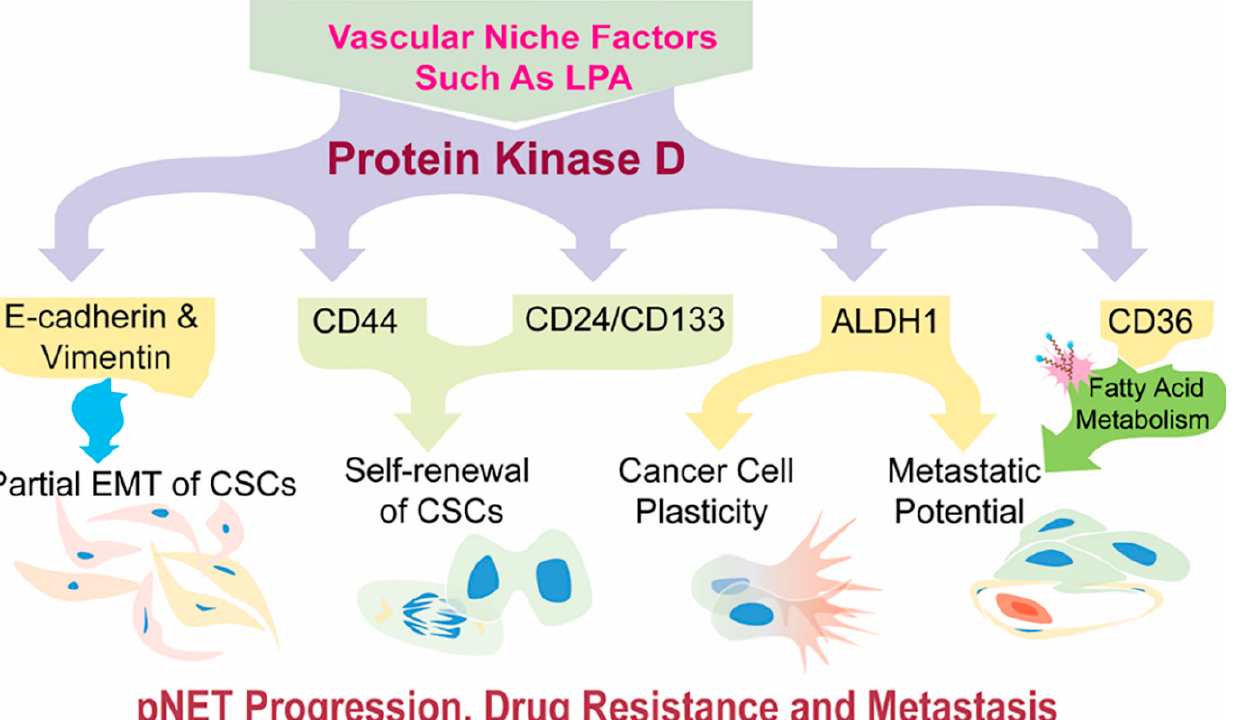
Figure 7. Working model: Regulation of CSCs with a plastic and partial EMT phenotype by PKD1 signaling in pNETs. PKD1 signaling may induce intermediate, or partial, EMT with a plastic phenotype in cancer stem-like cells, thereby endowing pNETs with robust invasive and pro-metastatic traits and drug resistance by regulation of different sets of stemness- and EMT-related gene expressions. Vascular niche factors, such as LPA, may contribute to the development of this phenotype in pNETs.